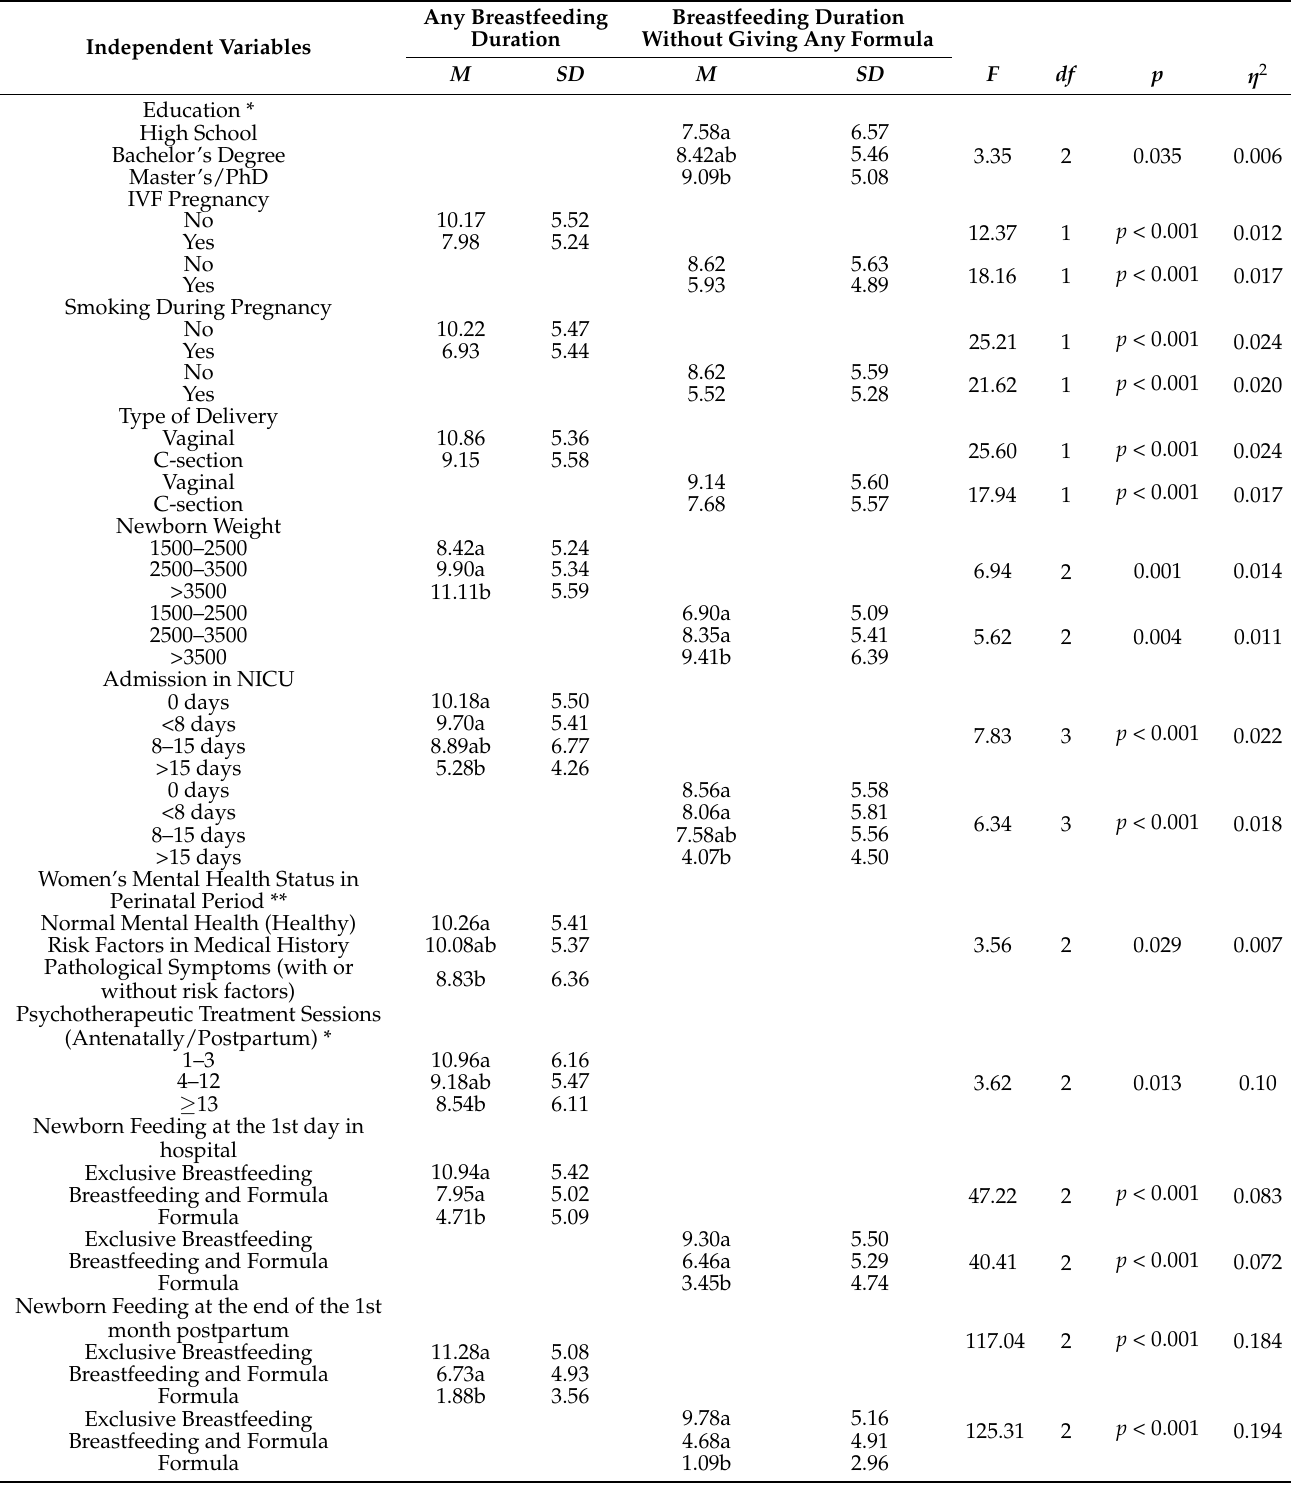
Table 4. Multivariate Analyses of Variance of Any Breastfeeding Duration and Breastfeeding Duration without Giving Any